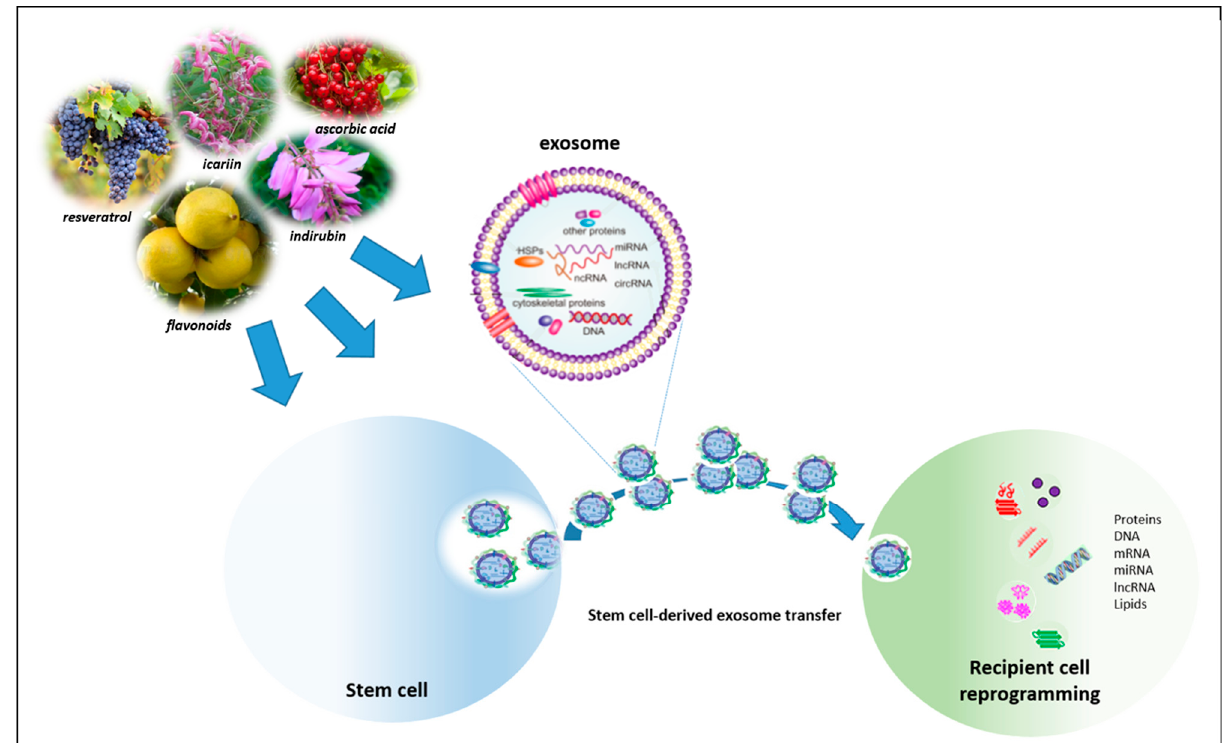
Figure 1. Potential properties of natural compounds in the stimulation of stem cell paracrine signaling. Some natural compounds (ascorbic acid, indirubin, resveratrol, icariin, bergamot polyphenols) emerging as useful tools in improving homing, engraftment, self-renewal and stem cell cardiovascular lineage specification, possibly, through paracrine signaling regulation. Stem cells exert paracrine effects on neighboring somatic cells via the secretion of micro-vesicles, such as exosomes, containing hundreds of different proteins, mRNAs and miRNAs under normal conditions or in response to cellular stress. Transferring the content of stem cell-derived exosomes can facilitate reprogramming of the recipient somatic cell.